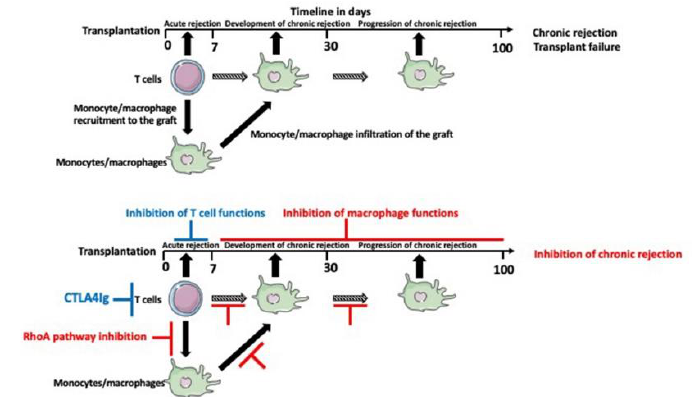
Figure 5. Timeline of transplant rejection and therapeutic intervention in the mouse cardiac trans- plantation model. The acute rejection, which occurs a few days after transplantation depends mainly on the T cells. The immunosuppressive drugs targeting T cells such as CTLA4Ig (in the mouse model) inhibit acute rejection but not the chronic rejection, which relies mainly on the mac- rophages. Administration of the RhoA pathway inhibitors within the first week of post-transplan- tation inhibits macrophage recruitment into the graft and inhibits chronic rejection.